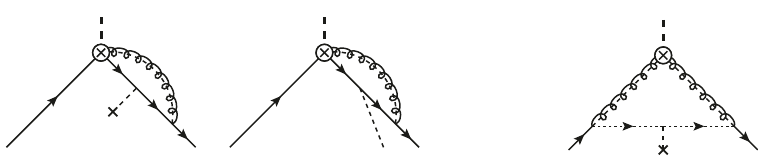
and Q L (cid:22) Q L G by means of L (cid:22) q R